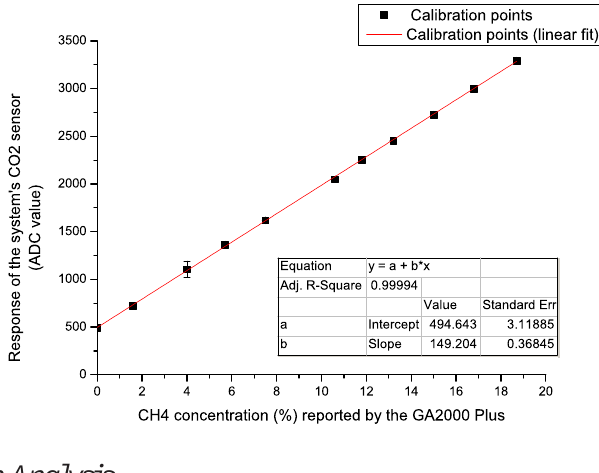
Figure 8. Calibration of the system’s CH 4 infrared gas sensor. Points represent the average of the steady state response over circa 2 minutes. Error bars (present but difficult to see due to the high sensor accuracy) represent the standard deviation.